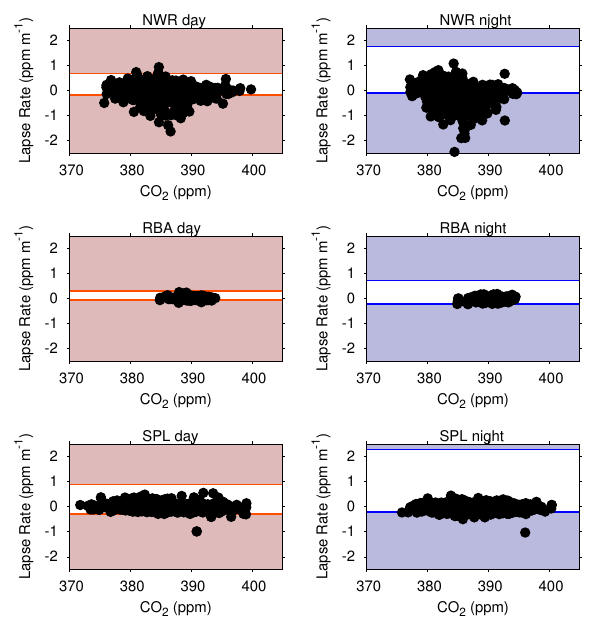
Fig. 9. SVLR: RACCOON station CO 2 lapse rate as a function of CO 2 mole fraction. Also included are the CT-2009 lapse rate ranges for the day (09:00–21:00LT) and night (all other hours). Lapse rate rejection ranges for day appear in red for each RACCOON station (NWR, RBA, SPL) on the left. Nocturnal rejection ranges appear on the right in blue. Using Niwot Ridge (NWR) as an example this figure shows that CarbonTracker lapse rate ranges fail to capture the full variability in CO 2 stratification, particularly for strongly stable conditions (negative lapse rates) at night caused for example by respiration and CO 2 pooling. Furthermore, during the day CarbonTracker appears less able to represent positive lapse rates than at night.